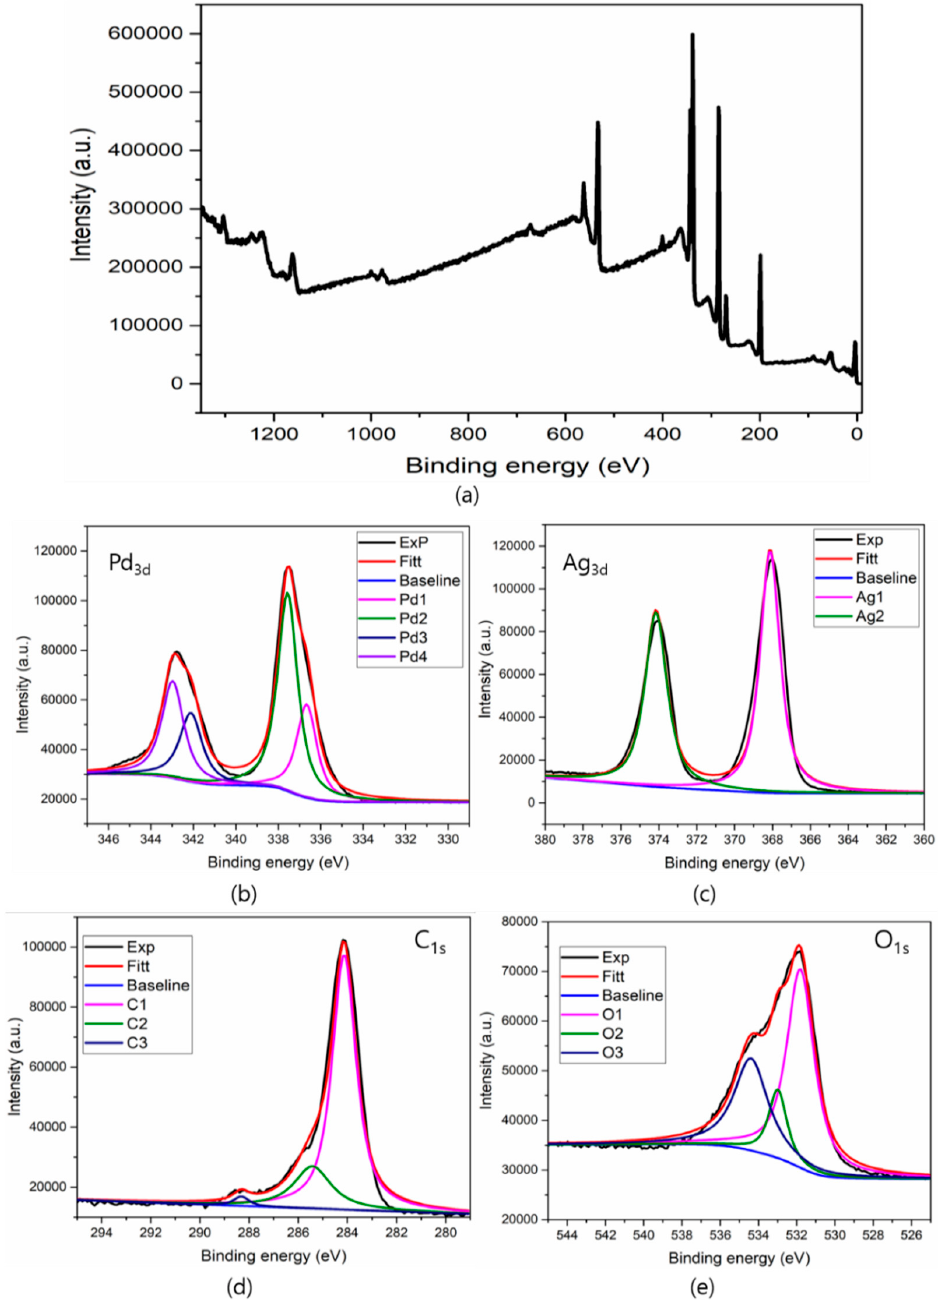
Figure 6. XPS spectra of Pd-Ag/RGO nanostructures ( a ) survey scan( b ) Palladium ( c ) Silver ( d ) Crbon and ( e ) Oxygen.